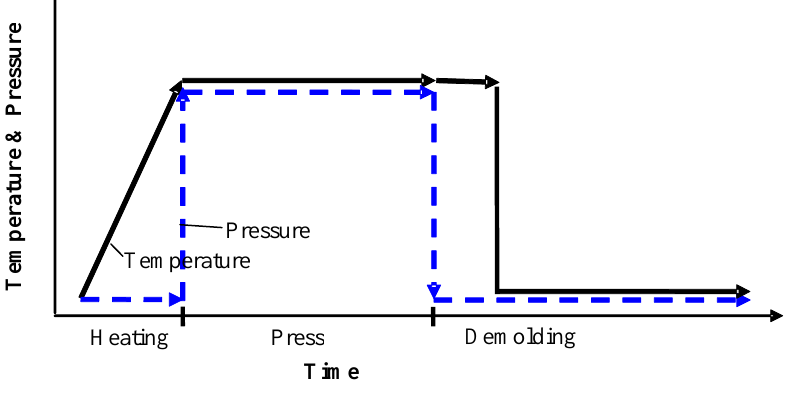
Figure 1. Diagram of the mechanical hot imprint process.